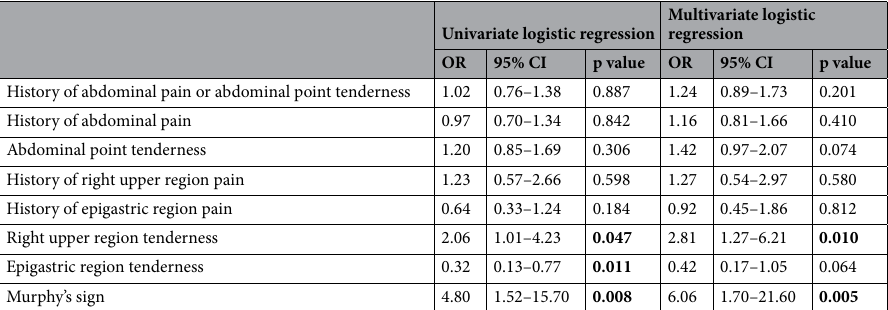
Multivariate logistic regression